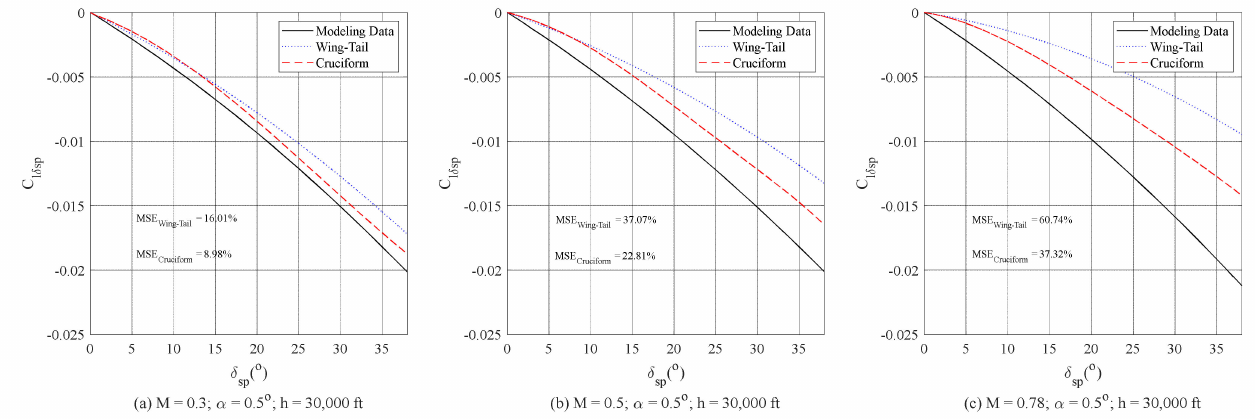
Figure 6. Comparison of the computation and experimental rolling moment coefficients: ( a ) in the flight states of M = 0.3, α = 0.5 ◦ , and h = 30,000 ft; ( b ) in the flight states of M = 0.5, α = 0.5 ◦ , and h = 30,000 ft; and ( c ) in the flight states of M = 0.78, α = 0.5 ◦ , and h = 30,000 ft.